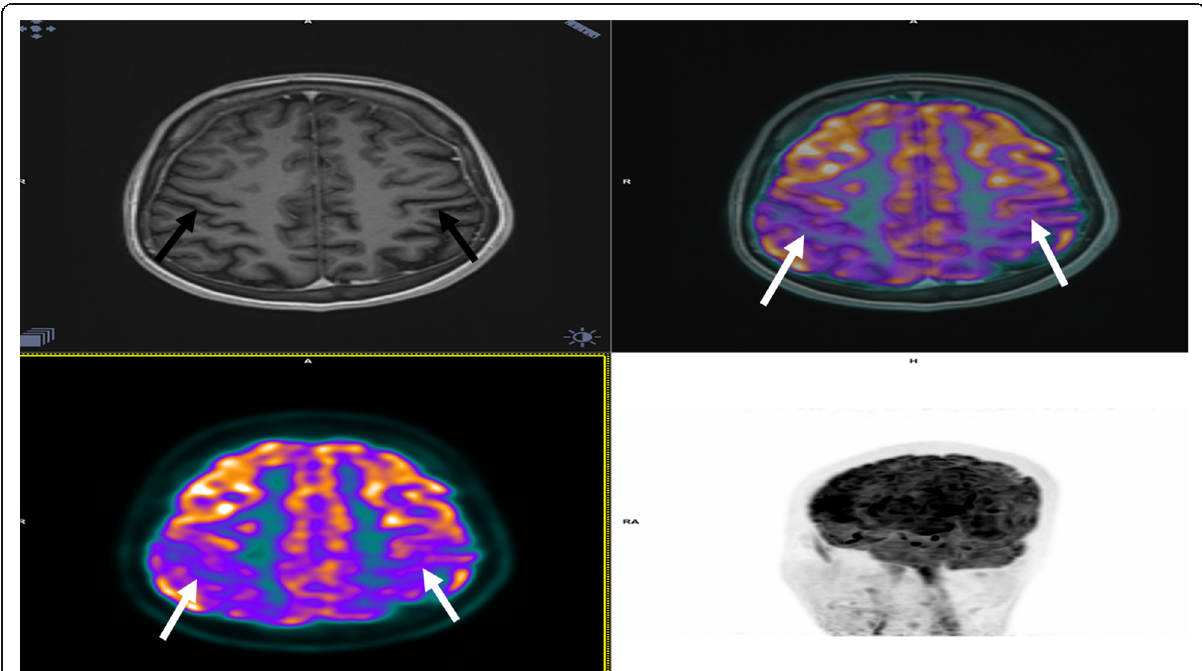
Fig. 5 Hybrid PET/MRI imaging of the brain. MRI of brain was suggestive of atrophy (black arrows) of bilateral precentral gyri with moderately decreased uptake of FDG in the corresponding areas (white